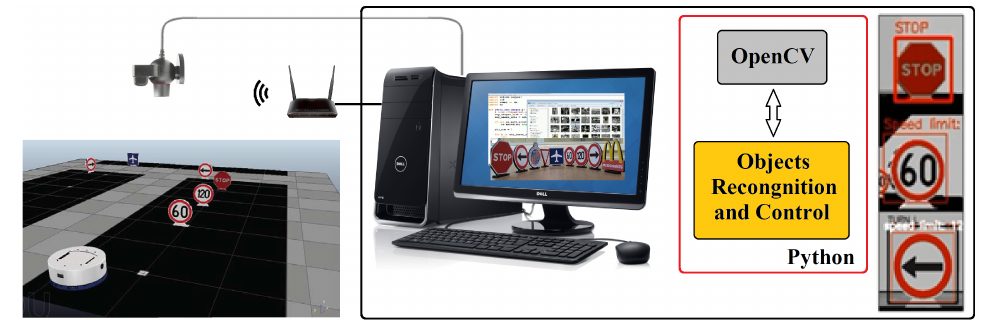
Figure 3. Diagram of the platform used for the experiments.